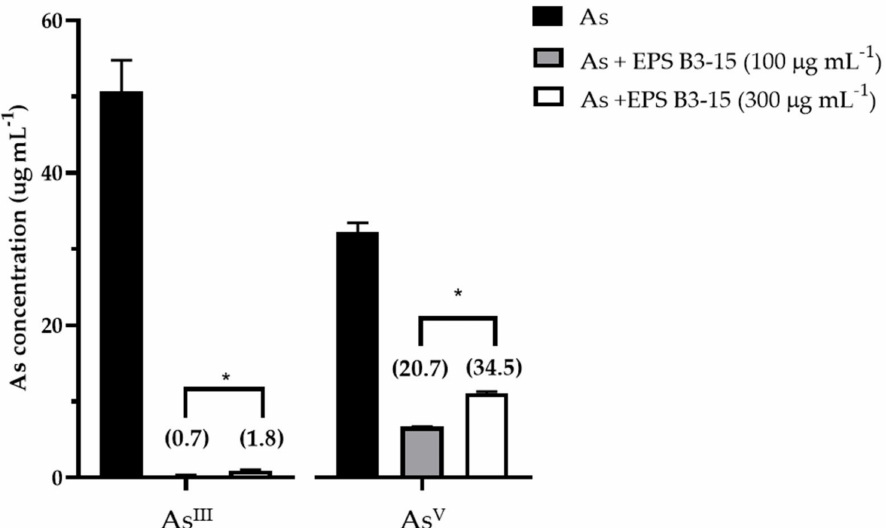
Figure 2. As III and As V concentration before and after 30 min treatment with EPS B3-15 (100 or 300 µ g mL − 1 ). In brackets are the data of EPS adsorption expressed in percentage. * Significantly different ( p ≤